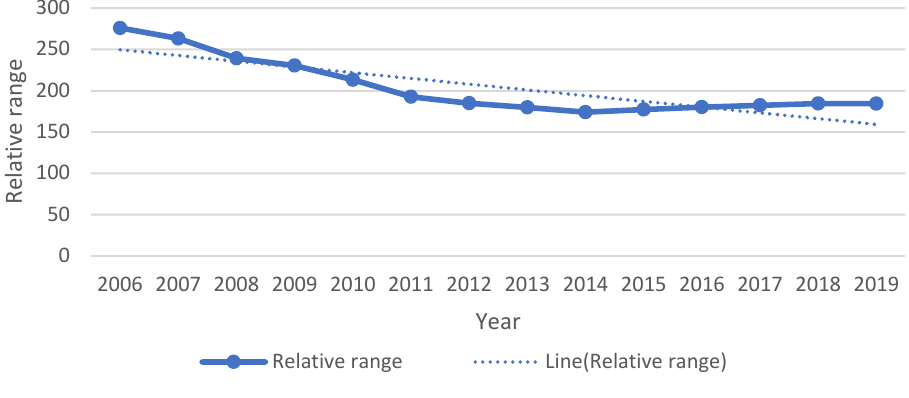
Figure 1. The absolute gap (range) of China’s per-capita GDP from 2006 to 2019.